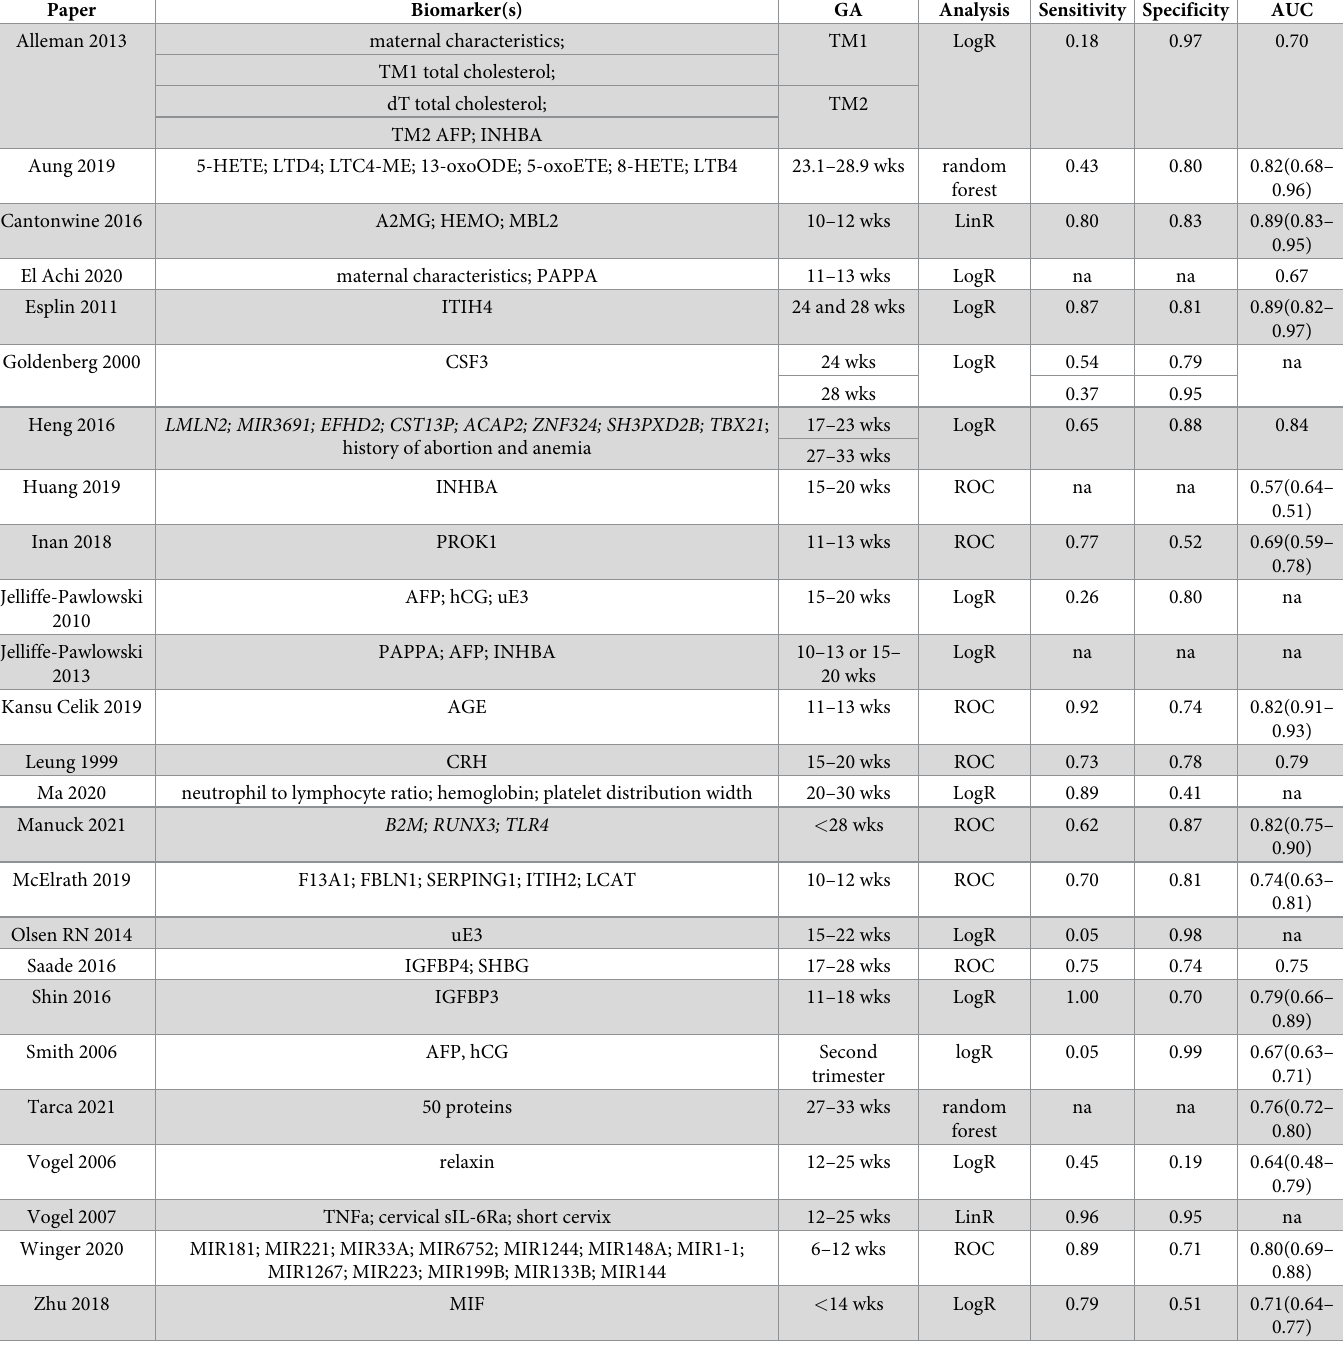
Table 2. Top prediction models for